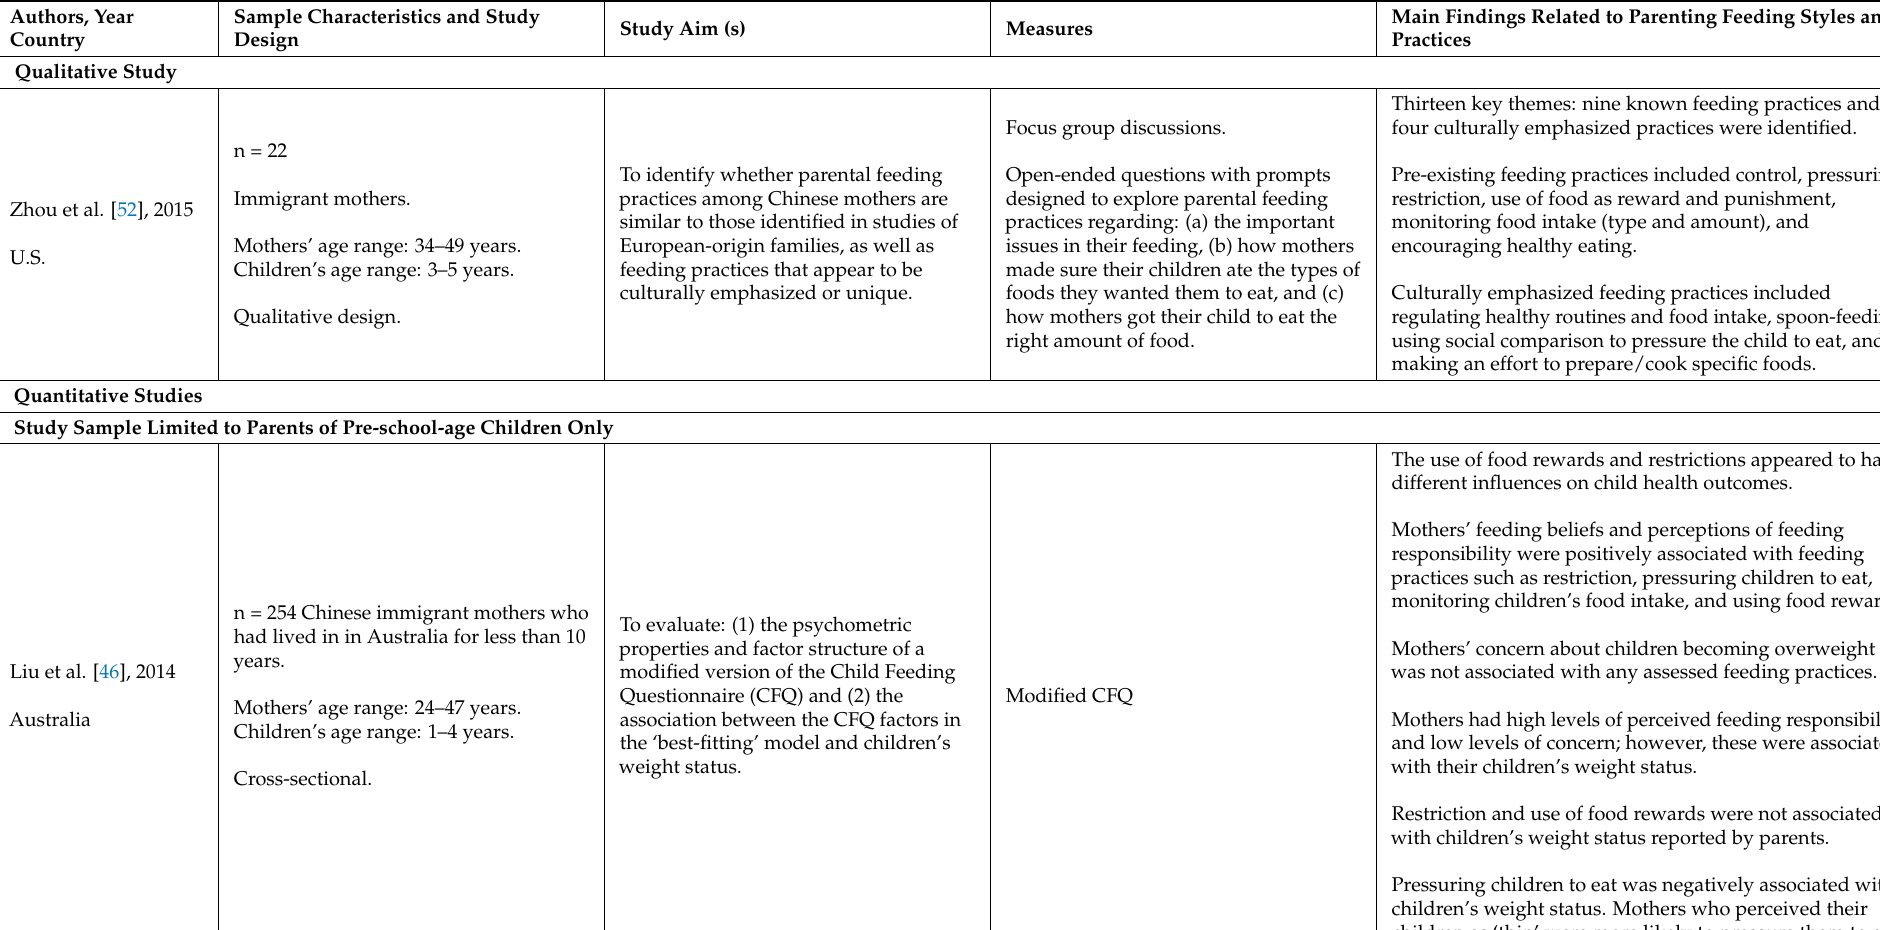
Table 4. Characteristics and findings of studies examining child-feeding beliefs, attitudes, knowledge, and practices of Chinese-immigrant mothers living outside China included in the integrative review (n =